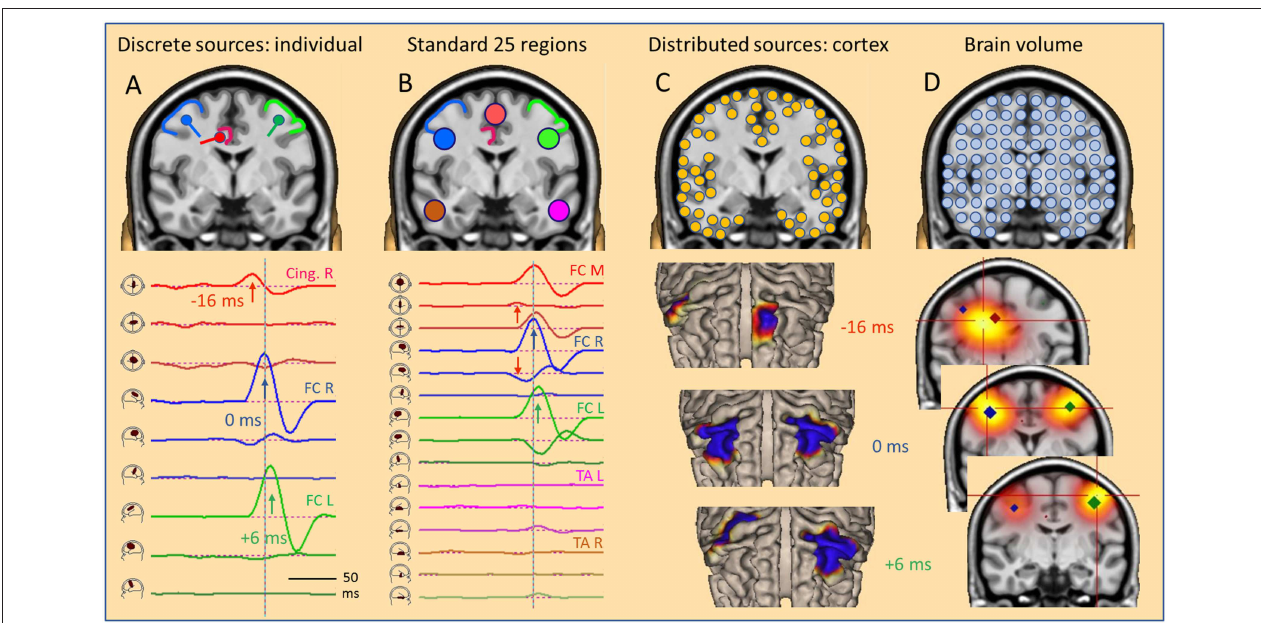
FIGURE 5 | The global source space. EEG/MEG can be modeled by: (A) multiple discrete sources (MDS) adapted to the individual data, (B) standard source regions, grossly distributed within the brain, (C) distributed sources confined to the gray-white matter boundary of the cortex, (D) sources distributed throughout the brain volume. Results in a simulated case of an IED propagating from right CG ( A , red) to right ( A , blue) and left frontal ( A , green) superficial cortex depend severely on the choice of global source space. With a small number of sources (A,B) , temporal dynamics is revealed by the source waveforms (bottom). However, the large number of sources in distributed models requires the display of a time series of images, either on the cortical surface ( C , cortical CLARA) or in the brain volume ( D , CLARA). Typically, distributed source images are calculated independently from one time point to the next. Thus, foci appear smeared and moving over time. Their extent depends more on scaling and other factors used to create the images than the underlying extent of active cortex. For more details see text.